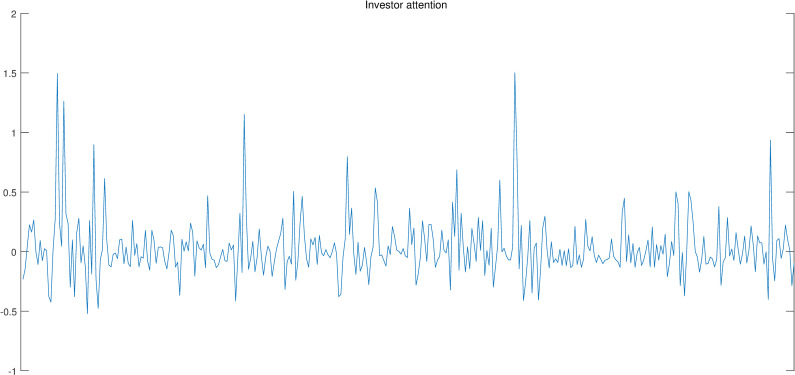
Investor attention.